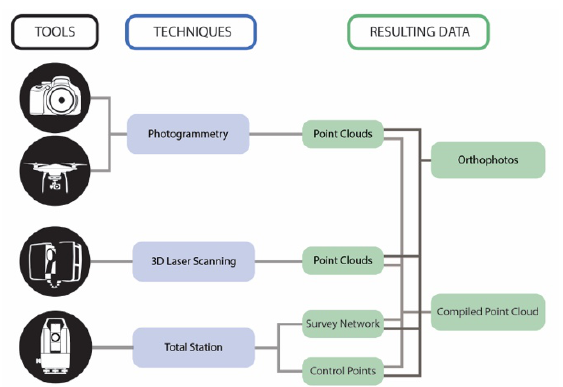
Figure 7. Workflow for the documentation technique, data collected, and outcomes